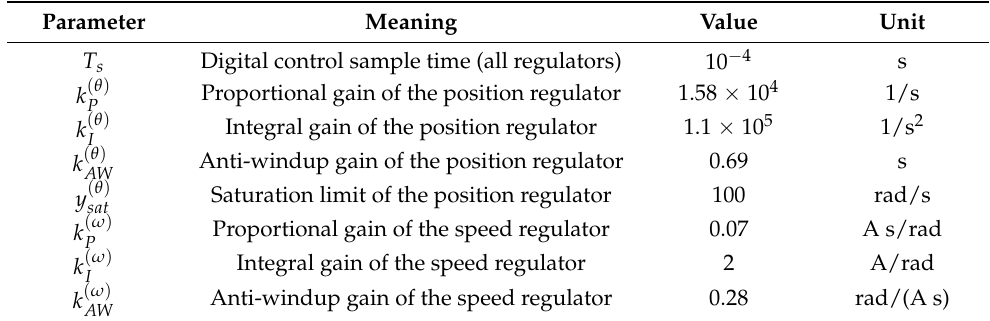
Table 4. Parameters of the electronic section of the